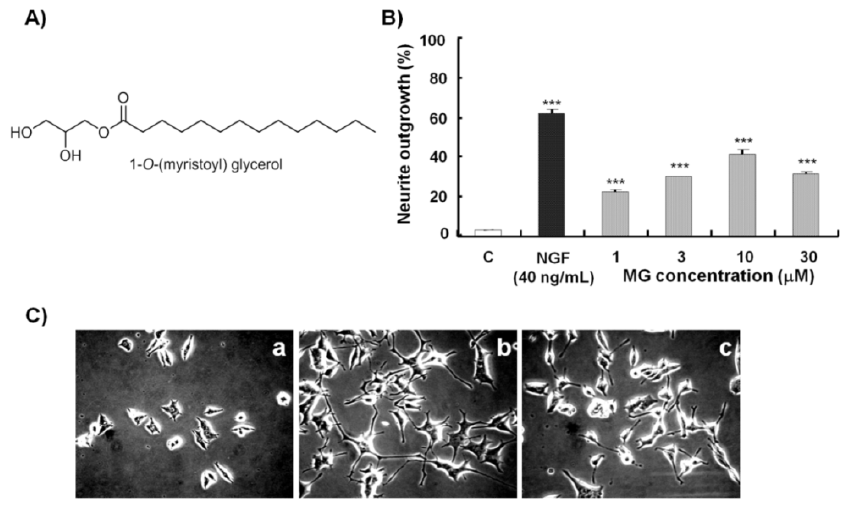
Figure 1. Chemical structure of MG, dose-dependent responses and photomicrographs of the NGF mimicking activity of MG 48 h after treatment. ( A ) Chemical structure of MG; ( B ) Percentage of neurite outgrowths of PC12 cells treated with MG at concentrations of 1, 3, 10 and 30 μM. C: solvent control (0.5% DMSO); NGF (40 ng/mL): positive control; and ( C ) Photomicrographs of PC12 cells obtained under a phase-contrast microscope 48 h after treatment: ( a ) solvent control (0.5% DMSO); ( b ) NGF (40 ng/mL); ( c ) MG (10 μM). Independent experiments were repeated three times. Each value represents the mean ± SEM of three replicates. ** and *** indicate significant differences relative to the control at p < 0.01 and p < 0.001,